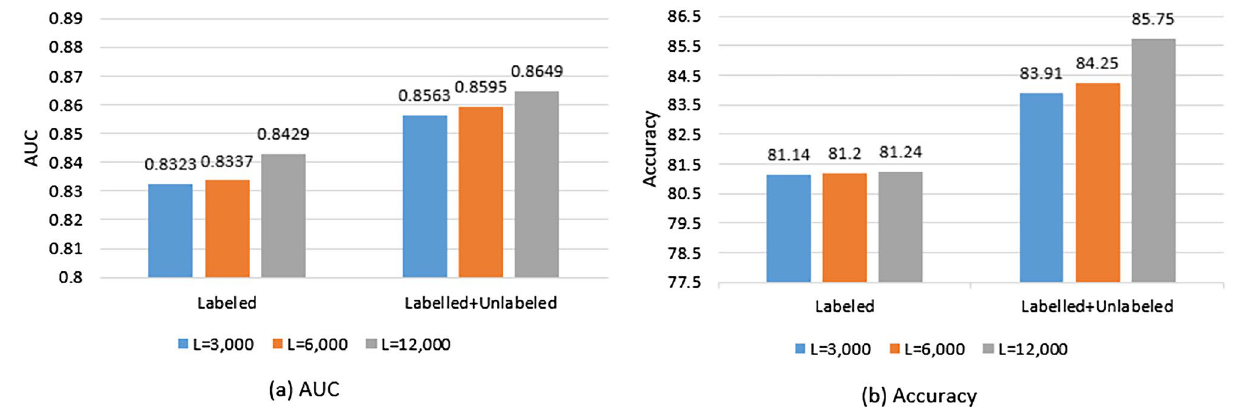
Figure 7. Neural network performance using labelled data only and mixed data(labelled and unlabelled) using different number of labelled data.